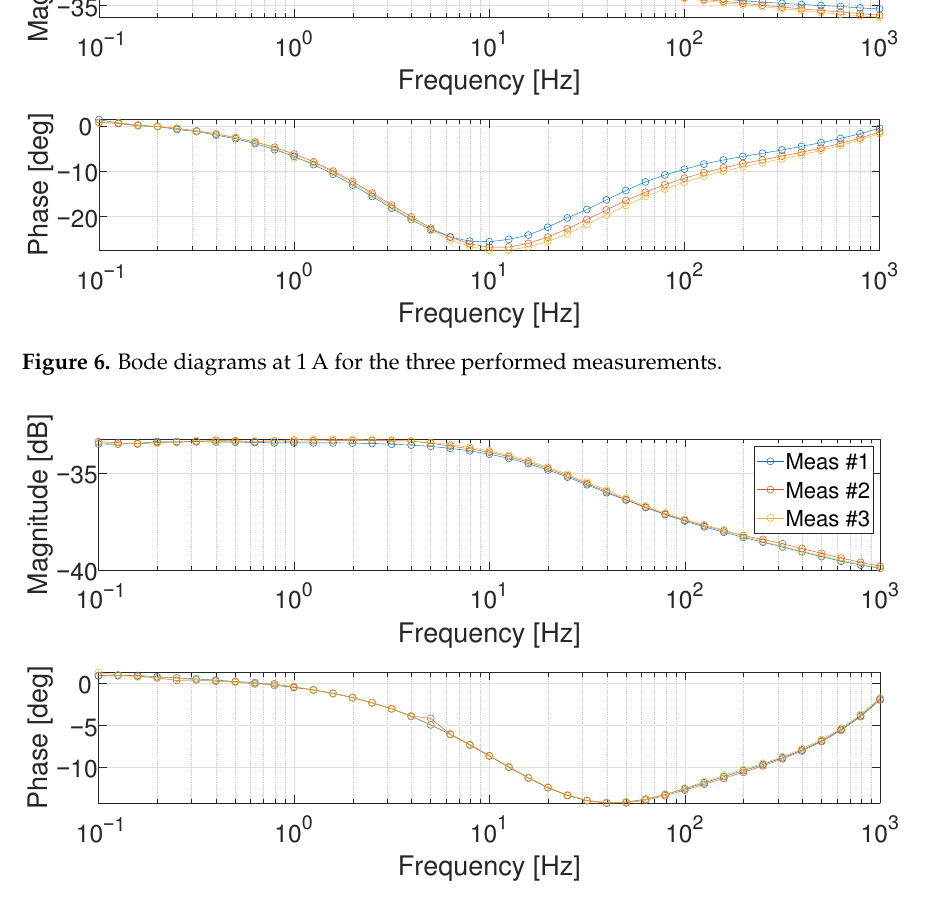
Figure 7. Bode diagrams at 5A for the three performed measurements.